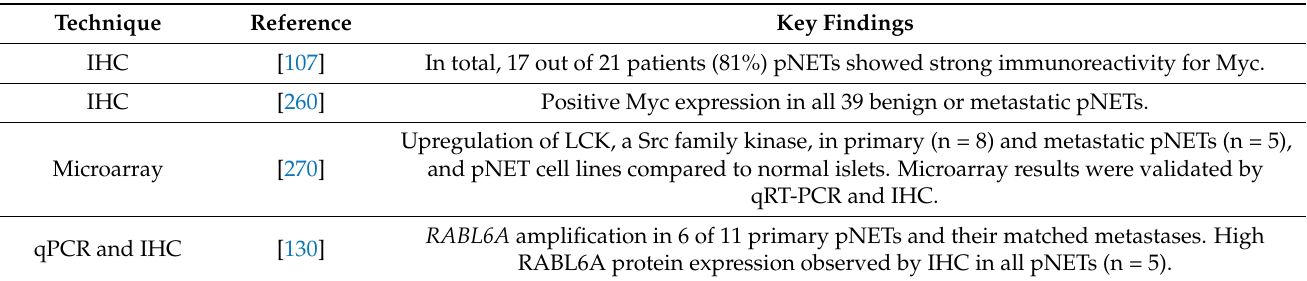
Table 10. Molecular profiling studies on miscellaneous pNET-associated proteins and pathways.